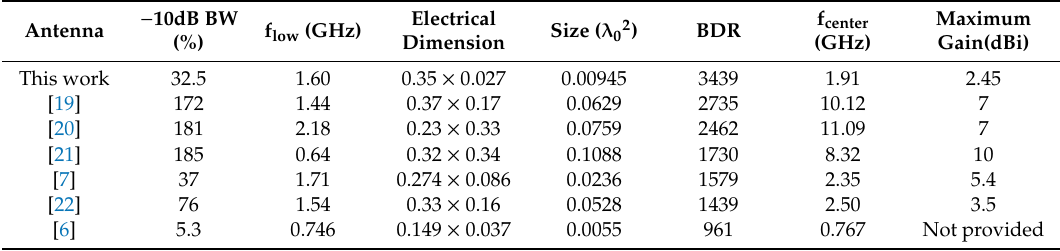
Table 2. Comparison of the proposed antenna with some recently reported antennae.